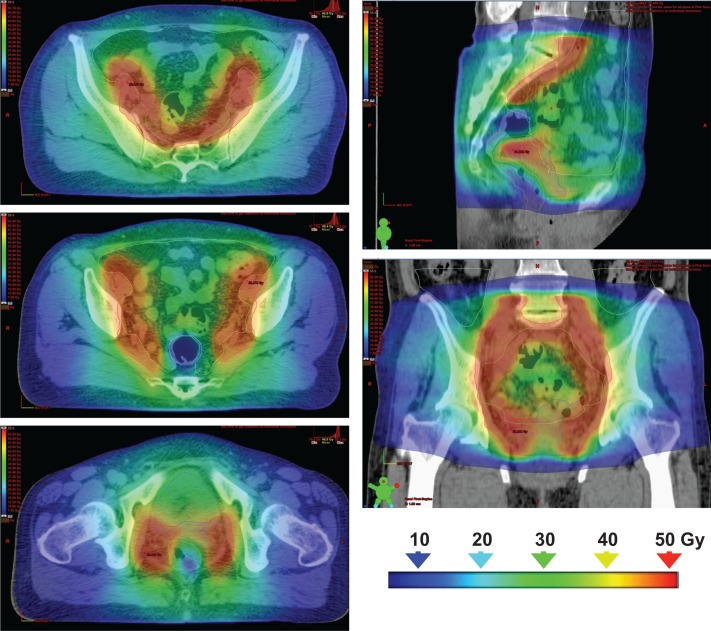
Dose distributions of the VMAT plan (same slices as for the case shown in Fig. 3): the figure shows the composite dose distributions of whole-pelvis irradiation (20 Gy/10 fractions) and pelvis irradiation with the central-shielding philosophy (30 Gy/15 fractions).